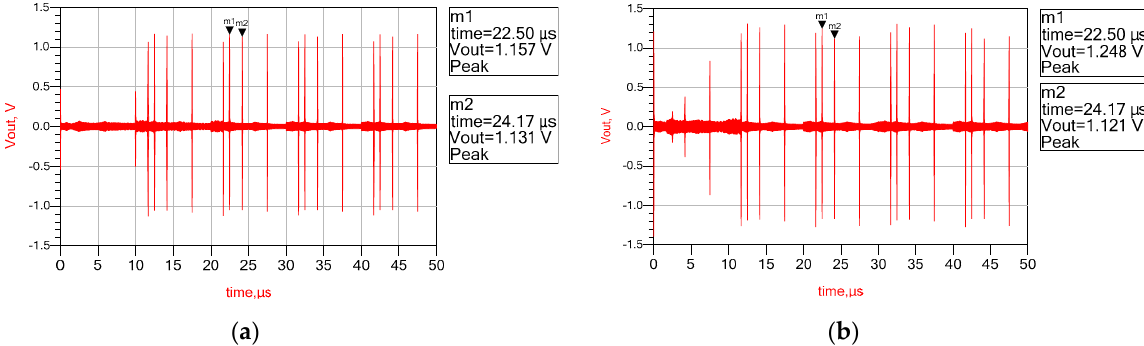
Figure 7. Output pulses of the four input frequencies. ( a ) is compressed by the classical two-channel CTS structure; ( b ) is compressed by the FCS M-C arrangement.